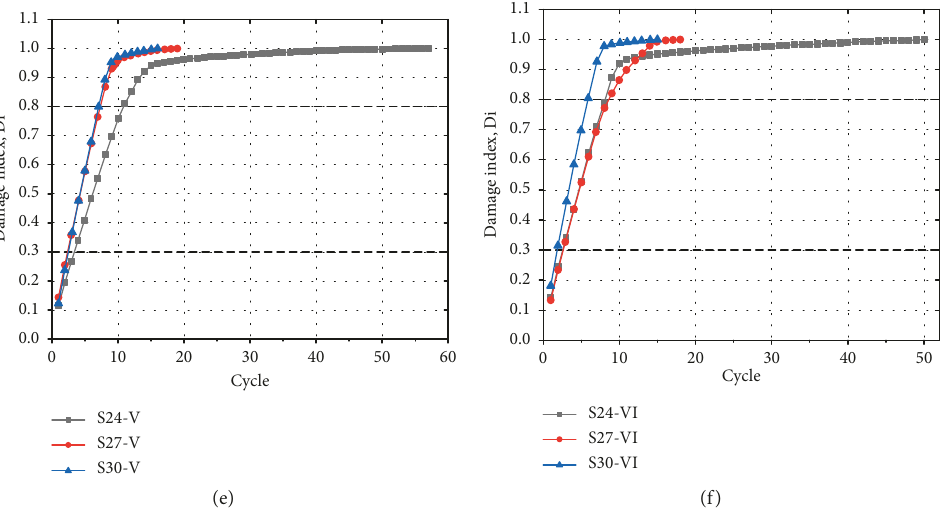
Figure 17: Damage index comparison. (a) Loading system I. (b) Loading system II. (c) Loading system III. (d) Loading system IV. (e) Loading system V. (f) Loading system VI.